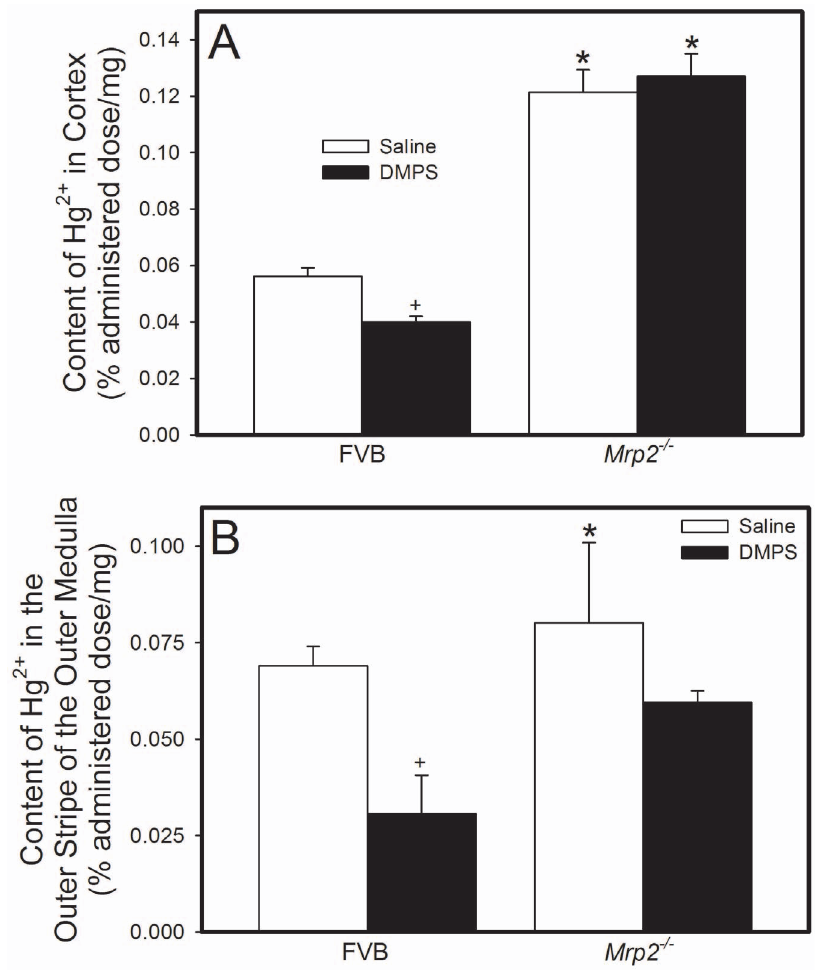
Figure 2. Content of Mercury in the Renal Zones of Mrp2 2 / 2 and FVB Mice. Mrp2 2 / 2 and FVB mice were injected intraperitoneally with a dose of 0.5 m mol ? kg 2 1 ? 8 mL 2 1 HgCl 2 . Samples from cortex (A) or outer stripe of outer medulla (B) were harvested 48 h after injection with HgCl 2 . Data are presented as percent administered dose per milligram of tissue in order to account for differences in sample weight. Data represent mean 6 SE of four mice. *, significantly different from mean of corresponding FVB mice (p , 0.05). + , significantly different from mean of mice from same strain treated with saline (p , 0.05).